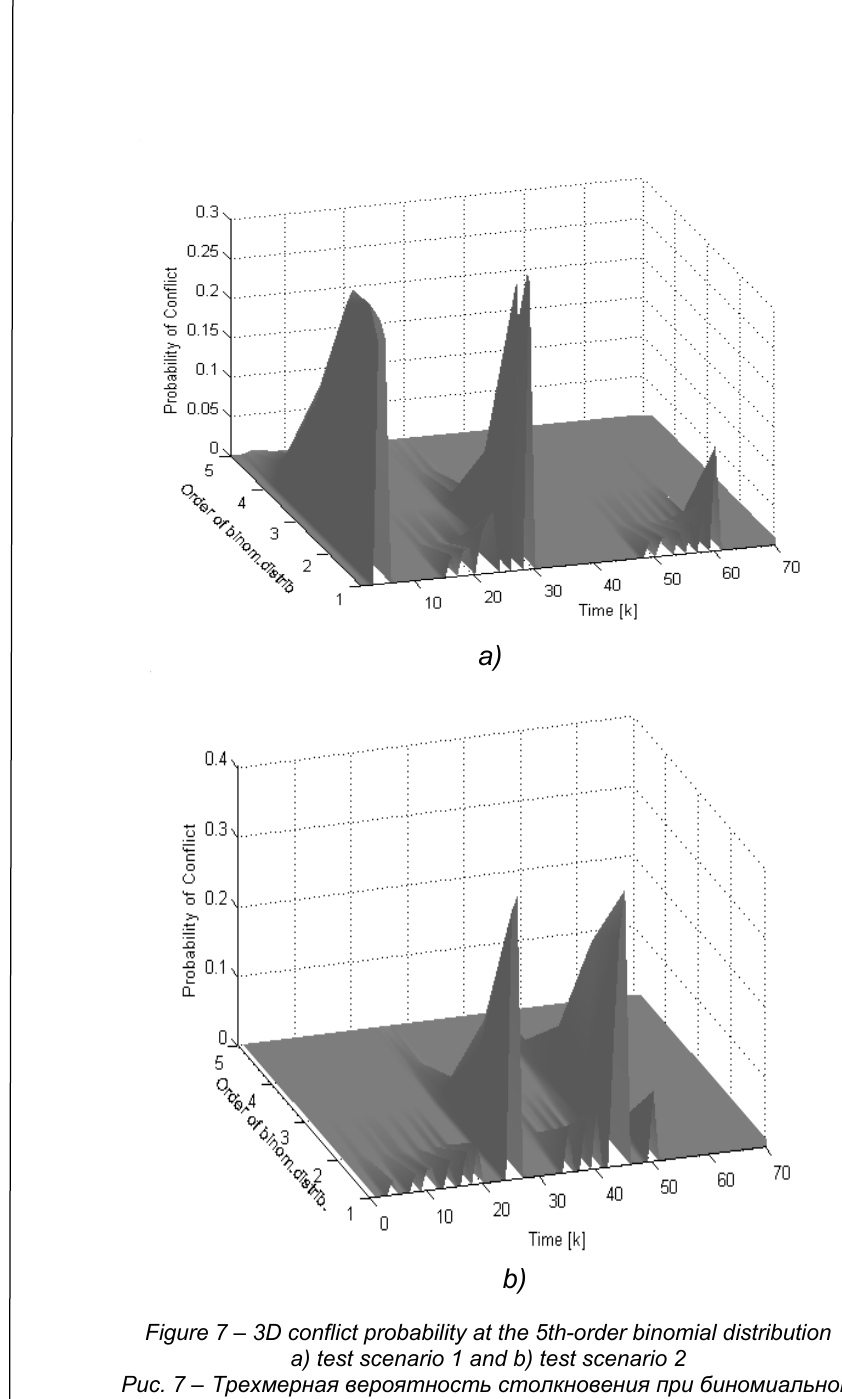
Figure 7 – 3D conflict probability at the 5th-order binomial distribution a) test scenario 1 and b) test scenario